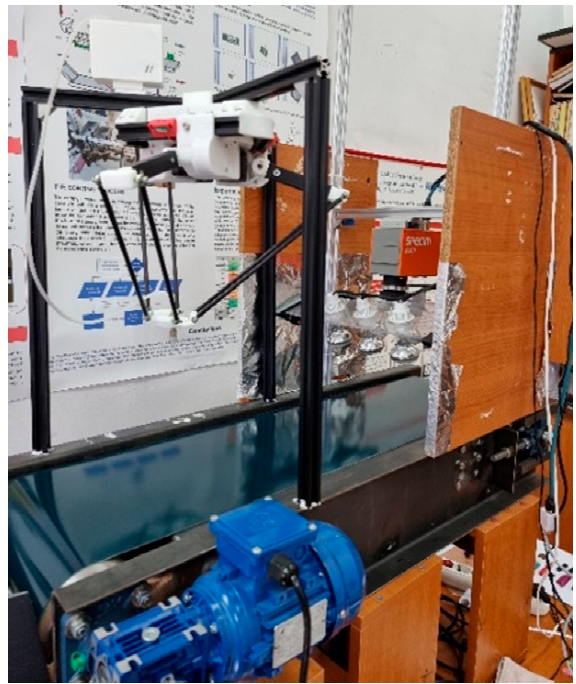
Figure 4. The first stage of the experimental sorting stand.